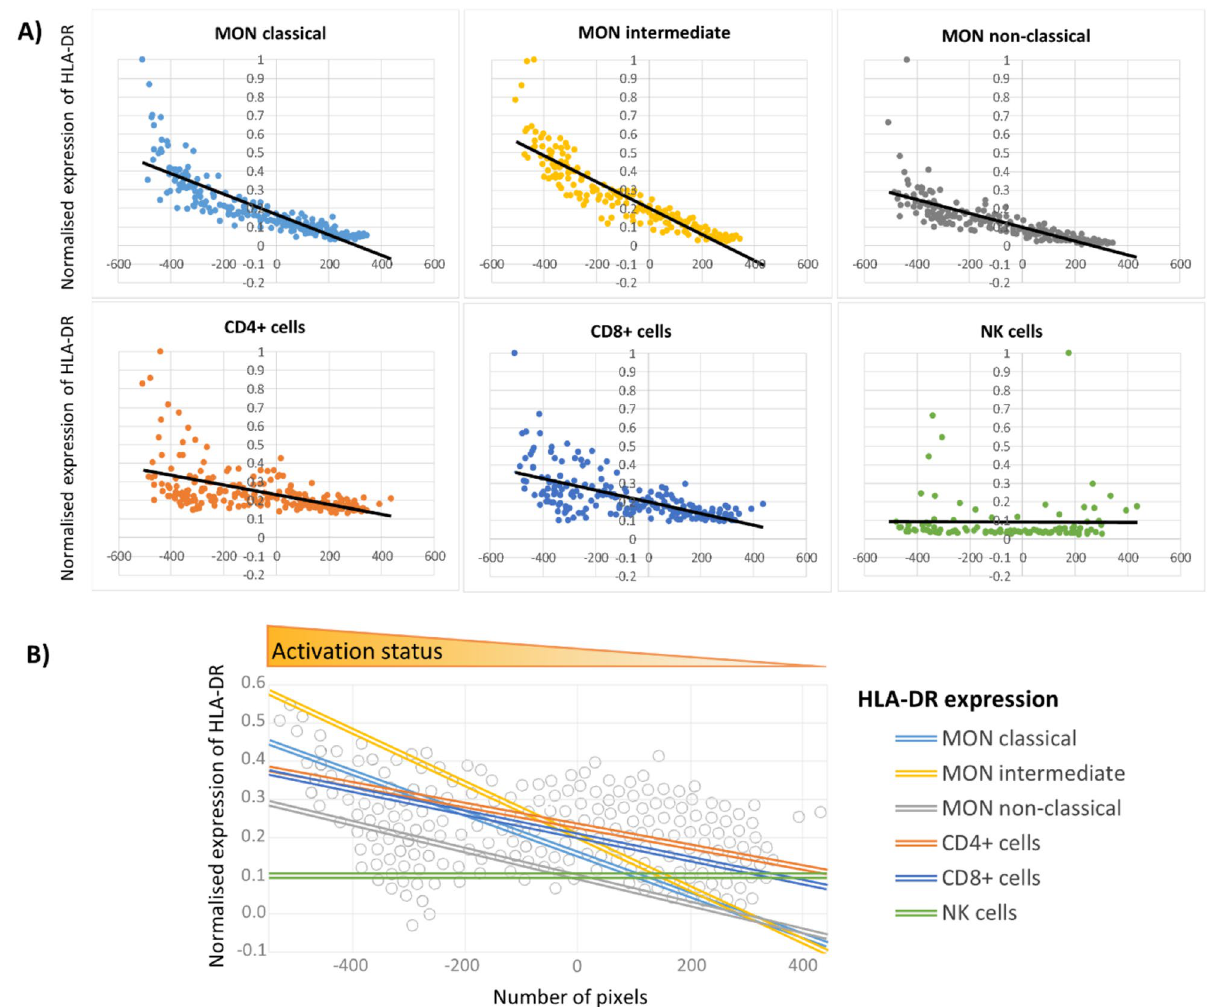
Figure 4. ( A ) Trend analysis of HLA-DR expression on monocyte (MON) subsets, CD4+ lymphocytes, CD8+ lymphocytes, and NK cells in PSN layout (presented in Fig. 3A). The y-coordinate of each dot in a scatterplot represents the expression value of studied markers in an individual patient. Values of all parameters were normalised to a maximum of 1 (the highest value in the data set). ( B ) Comprehensive visualisation of HLA-DR expression trends throughout the whole PSN. The unit on the x-axis is a pixel. The lines show the linear trend of the investigated parameter(s) obtained from scatterplots due to drug-induced redistribution of CLL cells between lymph nodes and circulation 25,26 , followed by a decline to almost zero values during the first year of treatment (Fig. 5A). Simultaneously, along with the decrease in the CLL count, the trend of increasing HLA-DR expression on classical and intermediate monocytes (Fig. 5A), as well as the non-classical monocytes and CD4+ and CD8+ T cells (data not shown), was detected during the first year of ibrutinib treatment, but not with idelalisib. CD64 expression on intermediate monocytes remained on the stable level (Fig. 5A). In patients treated with idelalisib, there was an evident decrease or stable level of CLL cell numbers during the first few months of treatment. However, compared to patients receiving ibrutinib treat- ment, the expression of HLA-DR and CD64 on monocytes had both a declining and an upward trend (Fig. 5B). HLA-DR expression on monocyte subpopulations does not differ between treatment-naïve CLL patients and healthy controls. Next, we analysed the differences in the activation of CLL and immune cells in treatment-naïve patients who required treatment (n = 61) within one year of sampling and treatment-naïve patients with the slow course (n = 38). Furthermore, all studied parameters were compared with those on CD19 + B cells from age- and sex-matched healthy subjects. Treatment-naïve patients who required treatment during follow-up exhibited higher percentages and numbers of CLL cells (both P < 0.001) and an elevated percentage of intermediate monocytes ( P < 0.001), compared to treatment-naïve patients with the slow course (median follow-up at 26 months). When comparing treatment- naïve CLL patients with healthy controls, the treatment-naïve patients with slow disease course did not differ from the healthy control subjects in terms of the activation of monocyte subsets (Fig. 6). The treatment-naïve patients requiring treatment within the one-year follow-up period had a lower activation on all monocyte subsets